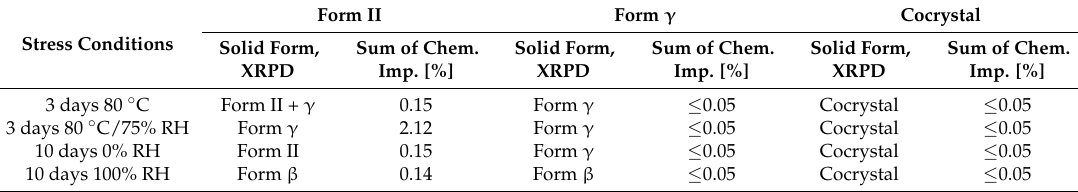
Table 5. The comparison of physical and chemical stability of different solid forms of ivabradine hydrochloride (polymorphic forms II, γ , and co-crystal) after the treatment at various temperatures and humidities.